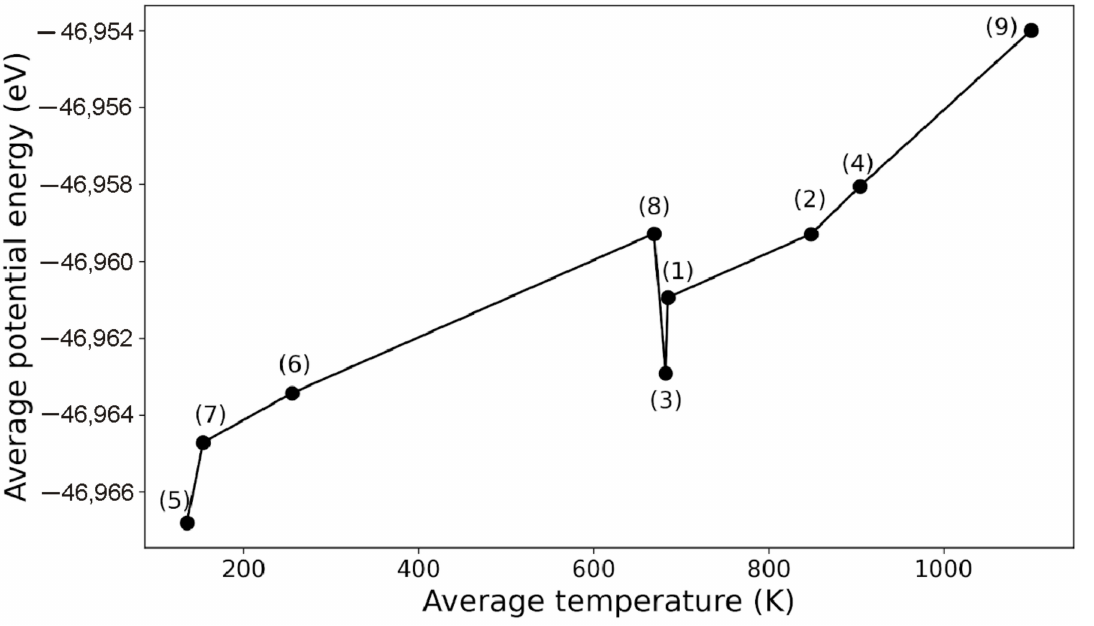
Figure 5. Dependence of the average potential energy on the average temperature for the calculated states of the LaScO 3 perovskite. The numbers indicate the series numbers from Table